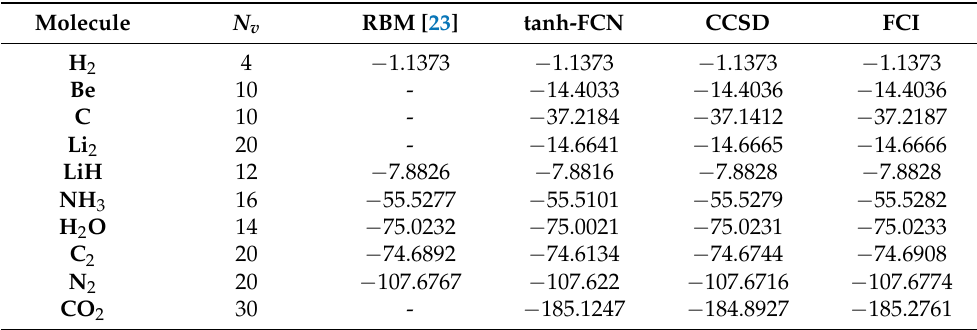
Table 1. List of molecules and the ground state energies computed using RBM, tanh-FCN, and CCSD. The FCI energy is also shown as a reference. The column N v shows the number of qubits. We have used N h / N v = 2 for all of the molecules